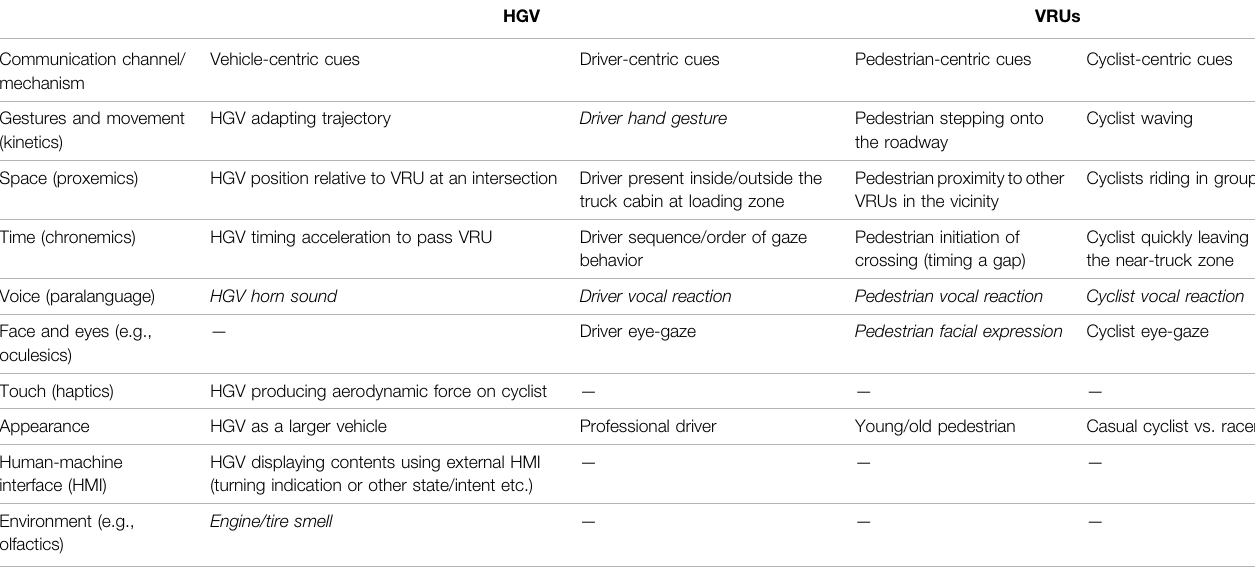
TABLE 6| Communication channels/mechanisms inHGV-VRU interactions,includingexamplesofextracted road user behaviors/communication cues (regular font) aswell as complementary examples added by the authors (italic